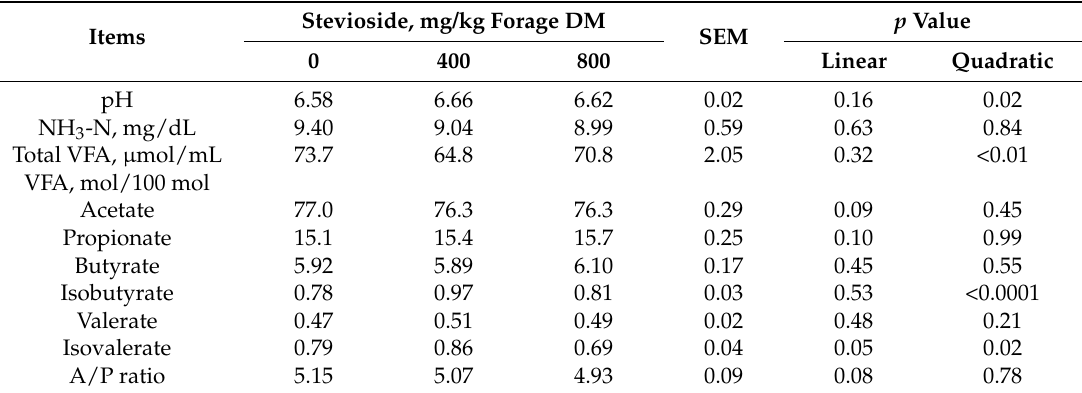
Table 3. Effects of stevioside on rumen fermentation in goats *.